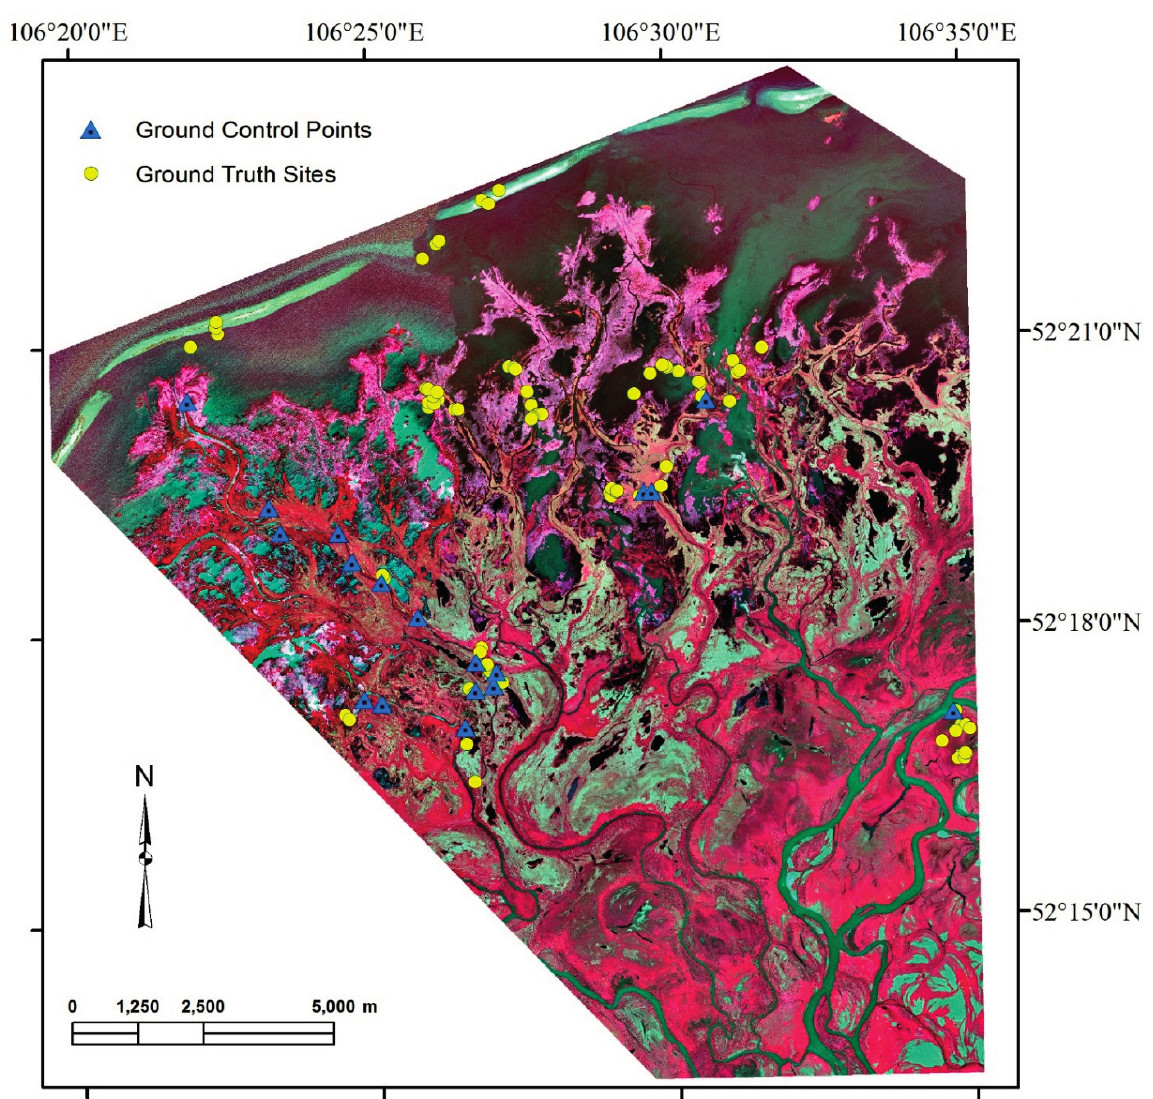
Figure 2. Adjacent WorldView-2 multi-spectral images (near-infrared false-color composite of bands 7, 5, and 3) with ground control points and ground-truth